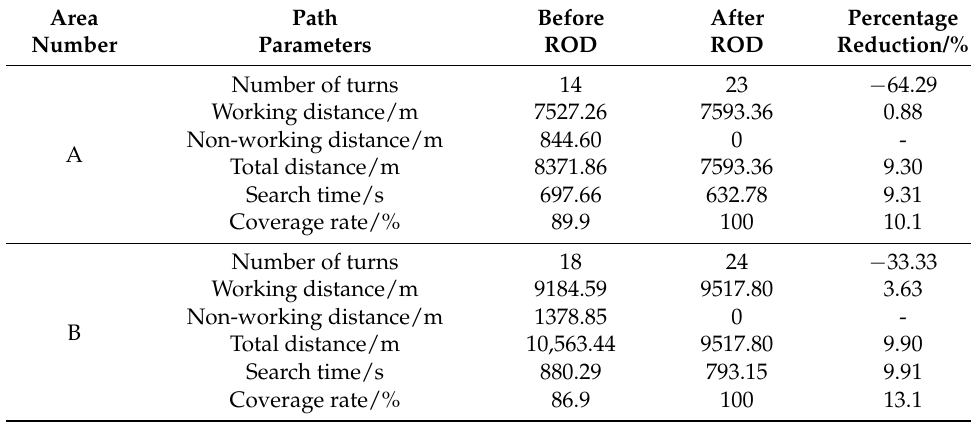
Table 10. Path comparison of five different areas before and after ROD.